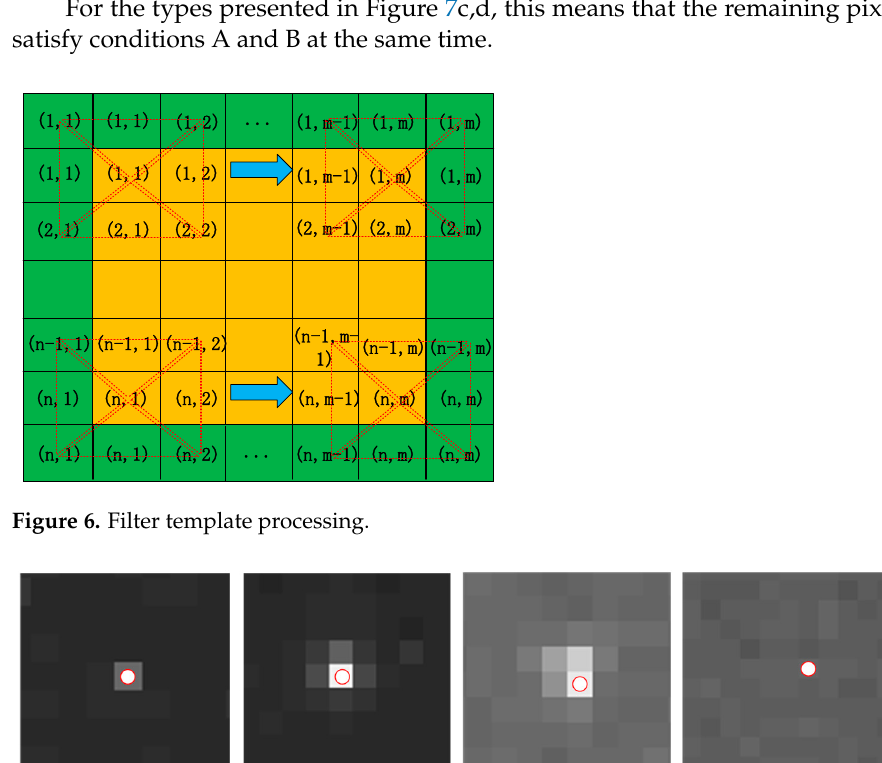
Figure 7. Four types of pixels in a star image: ( a ) a single pixel, which is characterized by a relatively bright pixel in the center and flat black pixels around it; ( b ) a standard central pixel of a star point, which is characterized by a relatively bright center pixel and approximate Gaussian distribution of the surrounding pixels; ( c ) an irregular central pixel of the Gaussian star point, which is characterized by a relatively bright pixel in the center and approximate Gaussian distribution on several sides, and the remaining part is the gentle background; and ( d ) pixels in a flat region with a small difference from the other pixels.